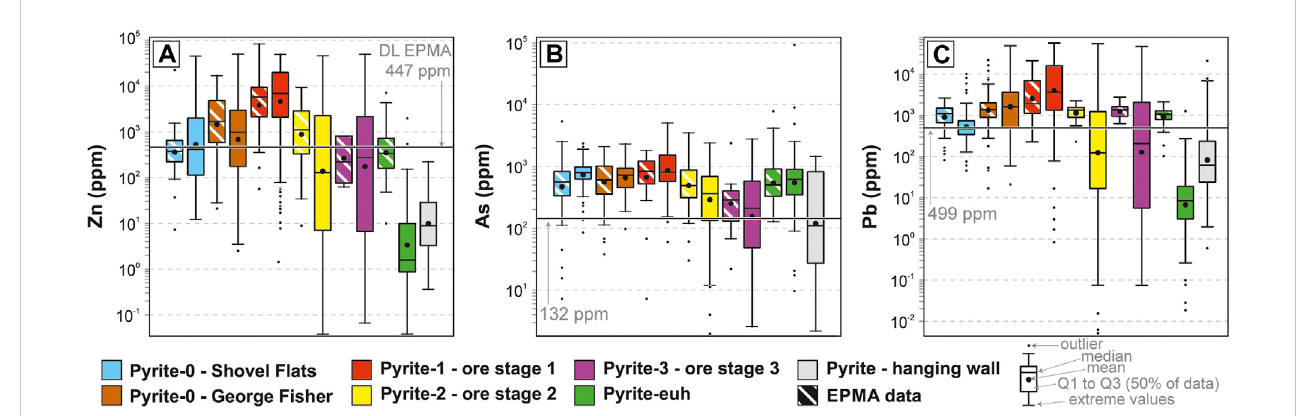
The abundance of Zn (A) , As (B) , and Pb (C) for individual pyrite sub-groups determined via LA-ICP-MS and EPMA. The black lines in (A – C) denote respectiveEPMAdetectionlimits(DL).ThetotalnumberofsamplesandanalysesofLA-ICP-MS(28samples,1,651analyses)exceedsthatofEPMA(22samples, 336 analyses). Note that EPMA results for below detection limit values are reported here but have large uncertainties. Shown are also statistical details for box and whisker plots used in this